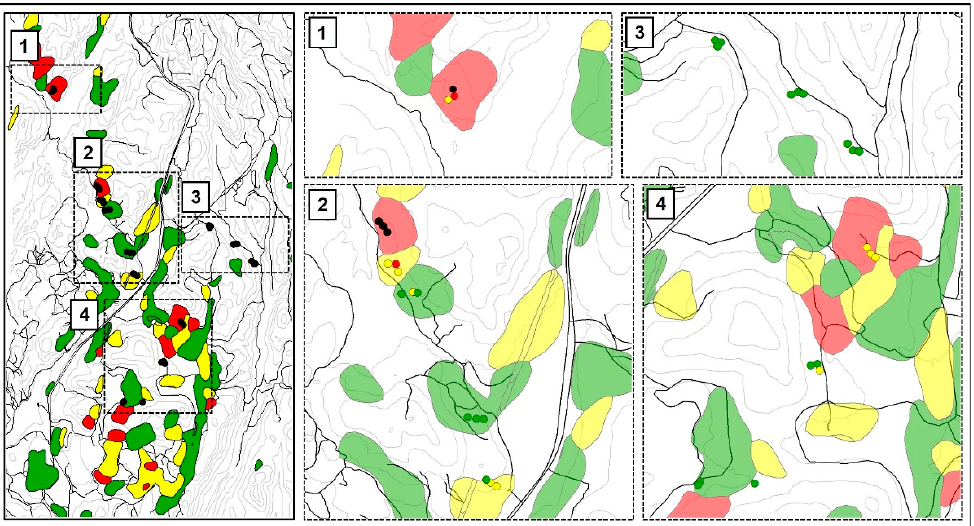
Figure 2. Aerial survey maps showing hemlock looper defoliation patches in the Reserve faunique des Laurentides in Quebec, Canada, in 2012. Three severity levels are shown: light (green), moderate (yellow), and heavy (red). The black dots on the left map show the study plot locations. The colored dots on maps 1–4 show corresponding ground-level defoliation estimates (light, moderate and heavy being the green, yellow, and red dots, respectively, and the black dots express the dominance of dead trees).